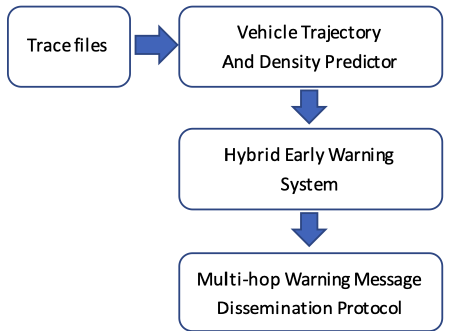
Figure 2. Flow chart of the proposed